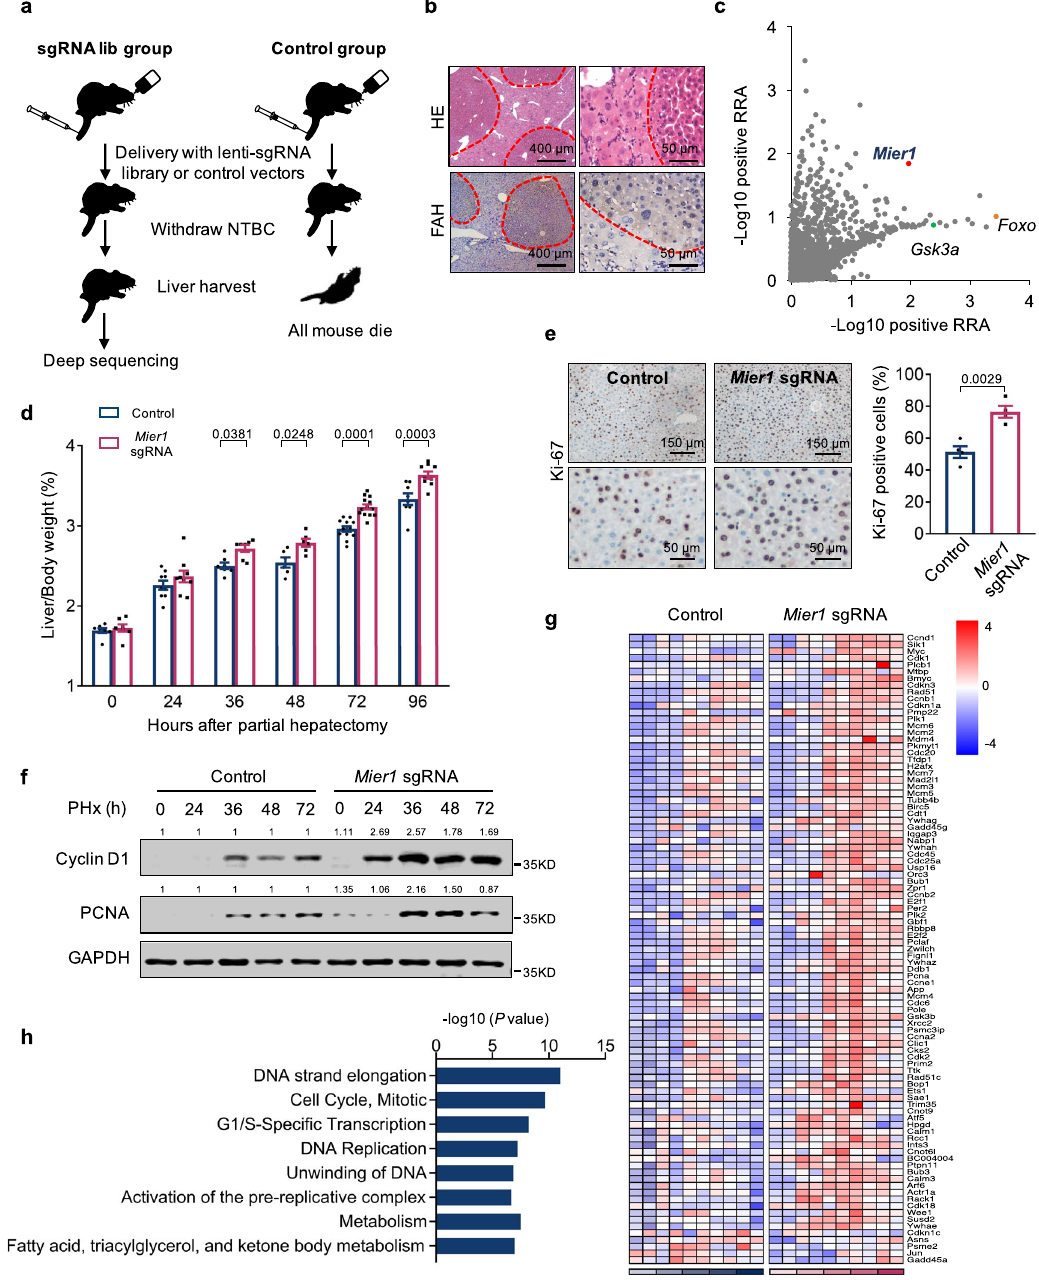
Fig.1|CRISPRinvivoscreeningidenti fi